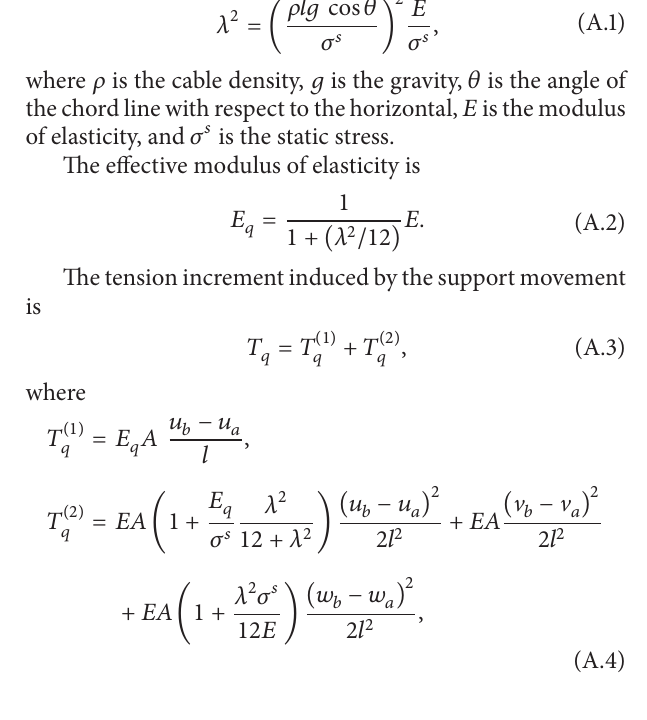
and 𝐹 𝑘 𝑤 are the reaction forces on the anchorage points ( a 𝑏 and b ) written in the local coordinates of the cable k (see 𝑛 𝐹 are the control forces of the n active cables Appendix). cont and are given in